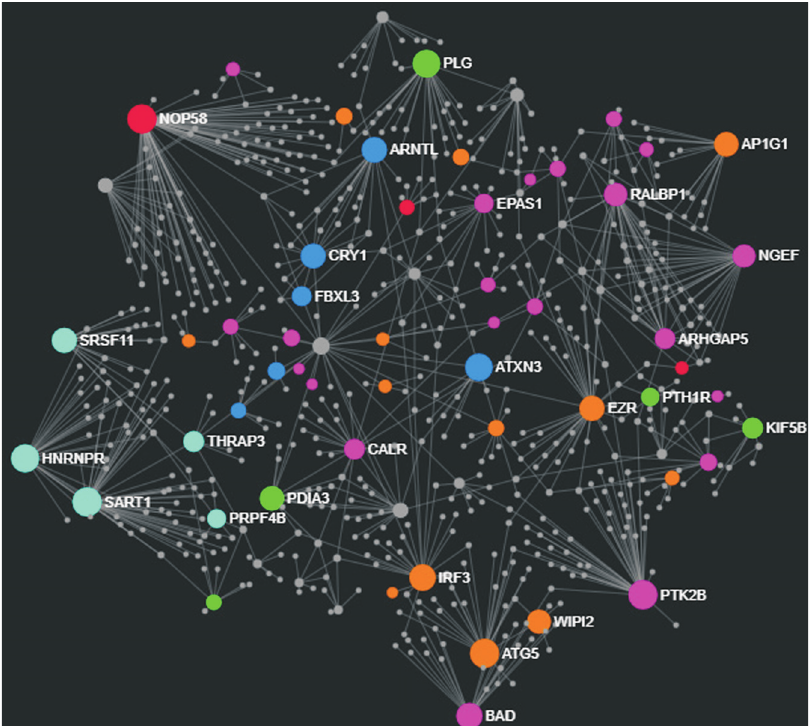
Figure 6 - Enriched hubs highlighting the main biological processes in the protein interaction network of the Brumado population. Hubs with different colorsrepresentpriorpathways;orange–cellularresponsetostress,darkblue–circadianrhythm,lemongreen–cellularhomeostasis,lightblue–mRNA processing, pink – cell signaling, and red – intracellular transport. Smaller grey hubs reflect interacting non-differentially expressed